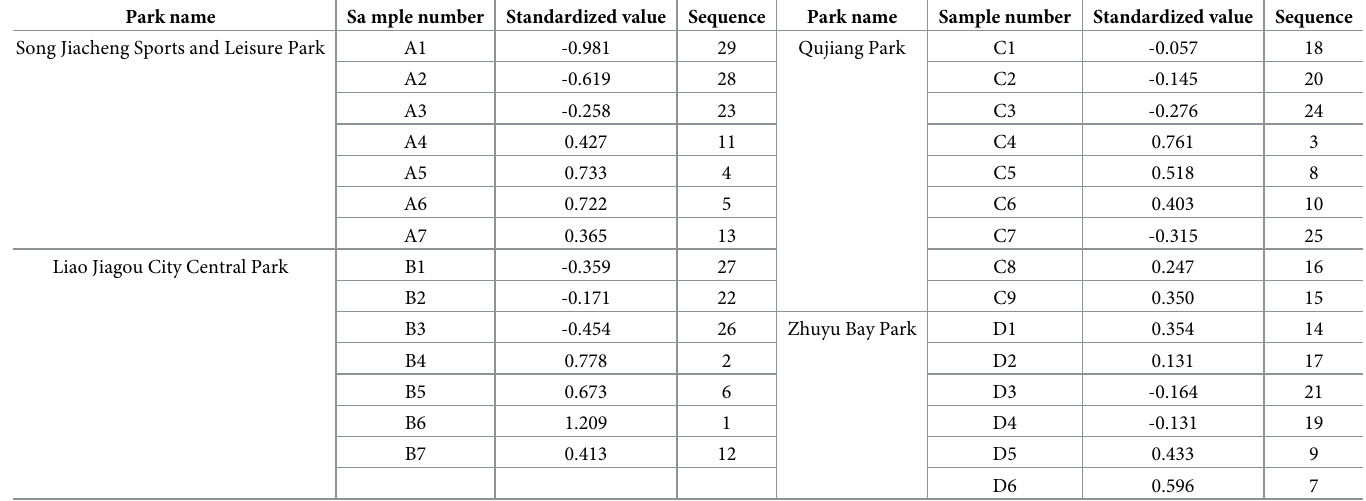
Table 2. Landscape beauty scores of 29 sample plant communities.